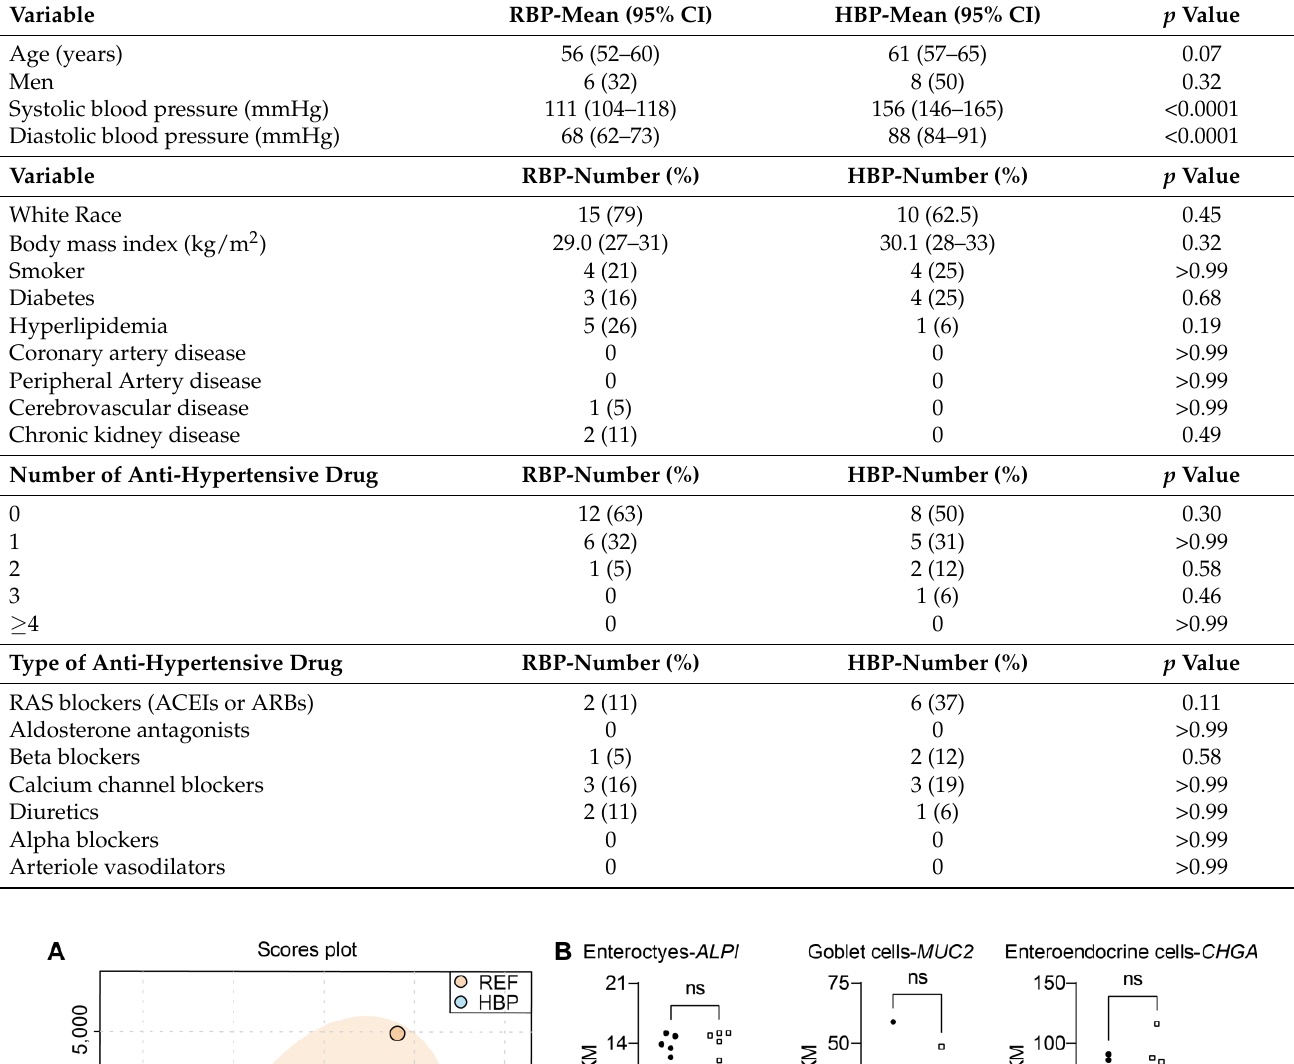
Table 1. Characteristics of subjects donating colon biopsies for study. p values were calculated using unpaired t- tests or contingency tests (Fisher’s exact) where appropriate.